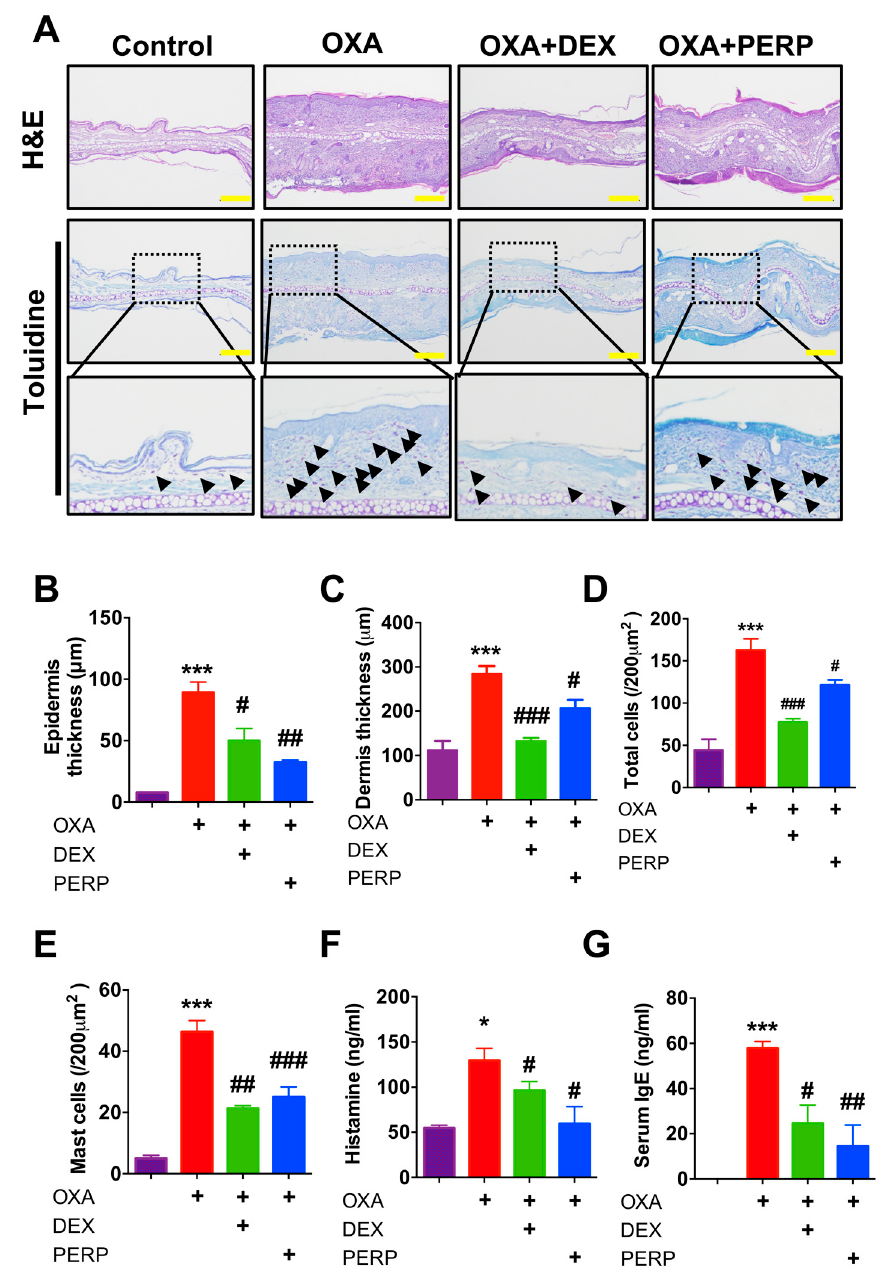
Figure 4. Perphenazine alleviates histological phenotype of OXA-induced dermatitis model in mice. ( A ) H&E staining and toluidine blue staining in ear lesions ( B ) Epidermal thickness ( µ m) was determined by micrometer. ( C ) Dermis thickness ( µ m) was determined by micrometer. ( D ) Total cells were counted. ( E ) Mast cells (black arrow) in dermis were counted. ( F ) Serum histamine levels were measured ( G ) Serum IgE levels were measured. Scale bar, 100 µ m. Data are presented as mean ± SEM of changes in values and analyzed by one-way ANOVA. (* p < 0.05, *** p < 0.005 compared to control) and (# p < 0.05, ## p < 0.01, and ### p < 0.005 vs. oxazolone treated).